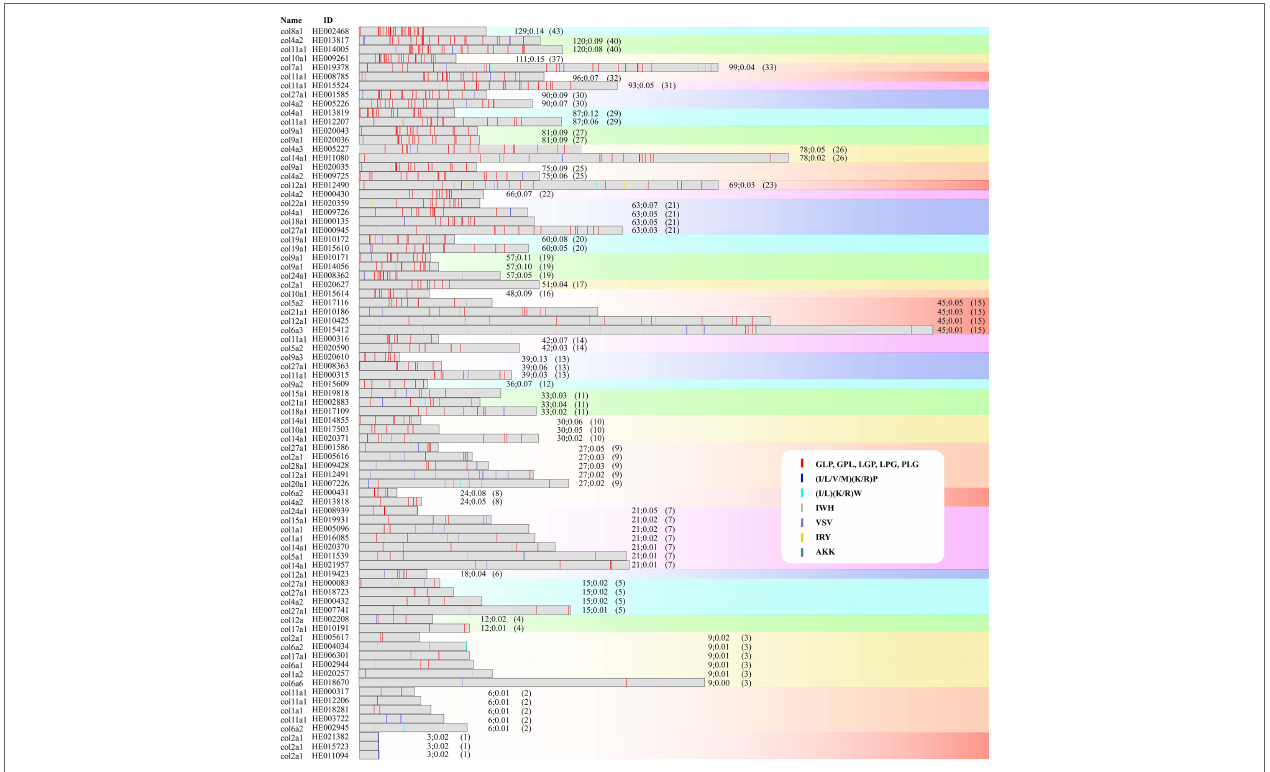
FIGURE 4 | Distribution of AHTPs in collagens. Gray bars indicate the collagen protein sequences. The coloured lines inside each bar stand for AHTP hits, and each color represents one AHTP type. Numbers after each bar refer to the total length of AHTPs in the protein, AHTP/protein ratio, and the number of AHTP hits, respectively. Protein sequences are sorted by the number of AHTP hits (from the highest to the lowest) followed by sequence length (from the shortest to the